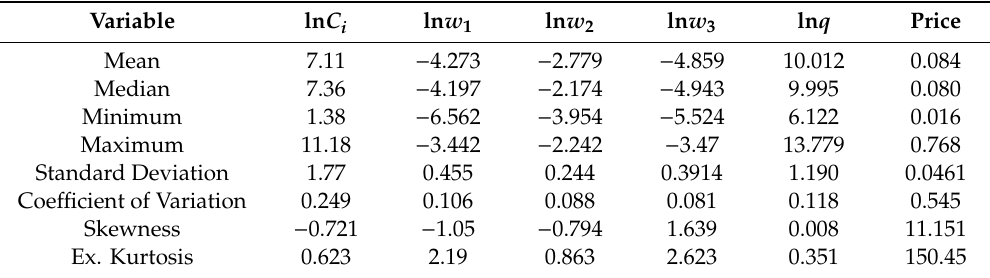
Table 1. Descriptive Statistics.